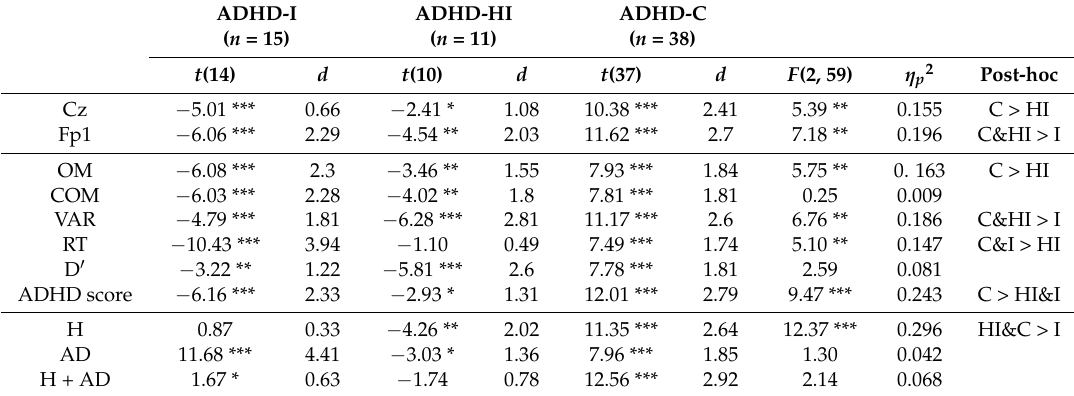
Table 3. Student’s t -Test and MANCOVA analyzing the gain and the differences between the types of presentation.